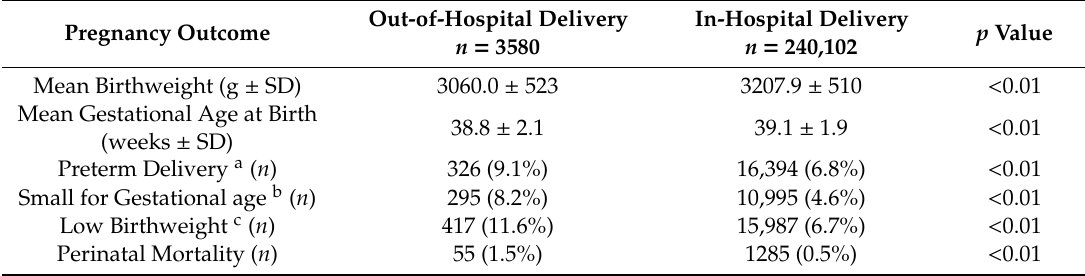
Table 2. Pregnancy outcomes for mothers with unplanned out-of-hospital delivery compared to in-hospital deliveries.